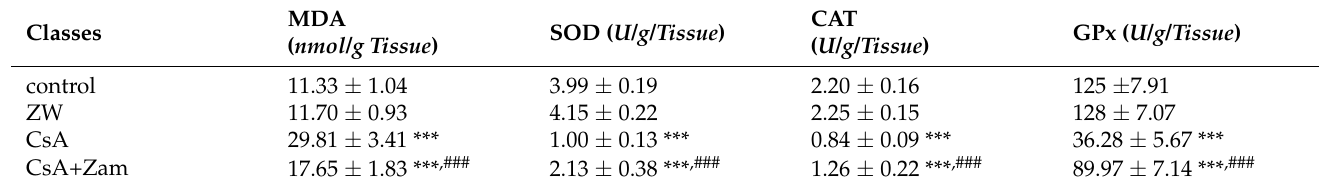
Table 3. Renal antioxidant enzymes and oxidative stress biomarkers in the experimental